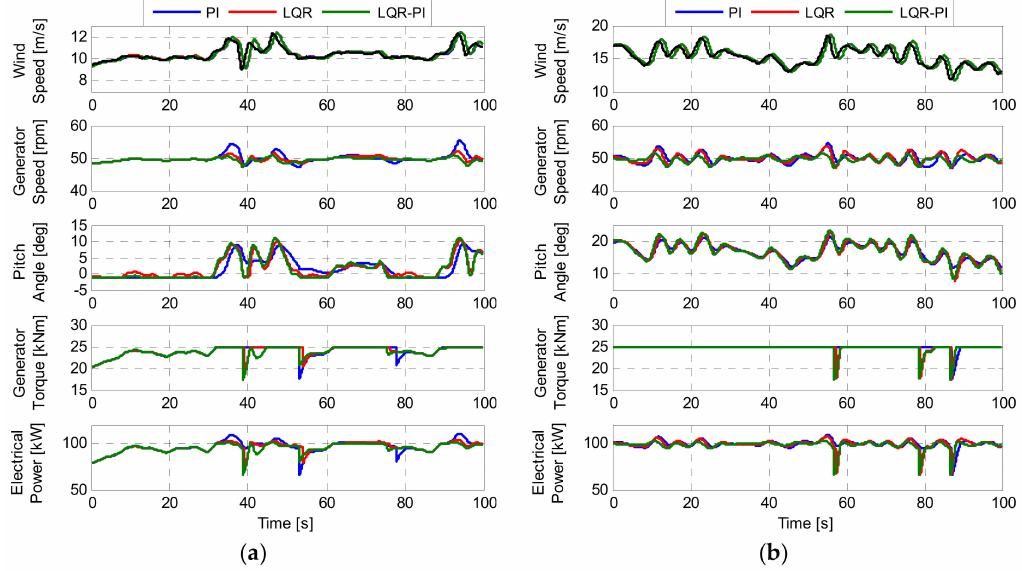
Figure 14. Simulation results according to the control method applied. ( a ) Transition region; ( b ) rated power